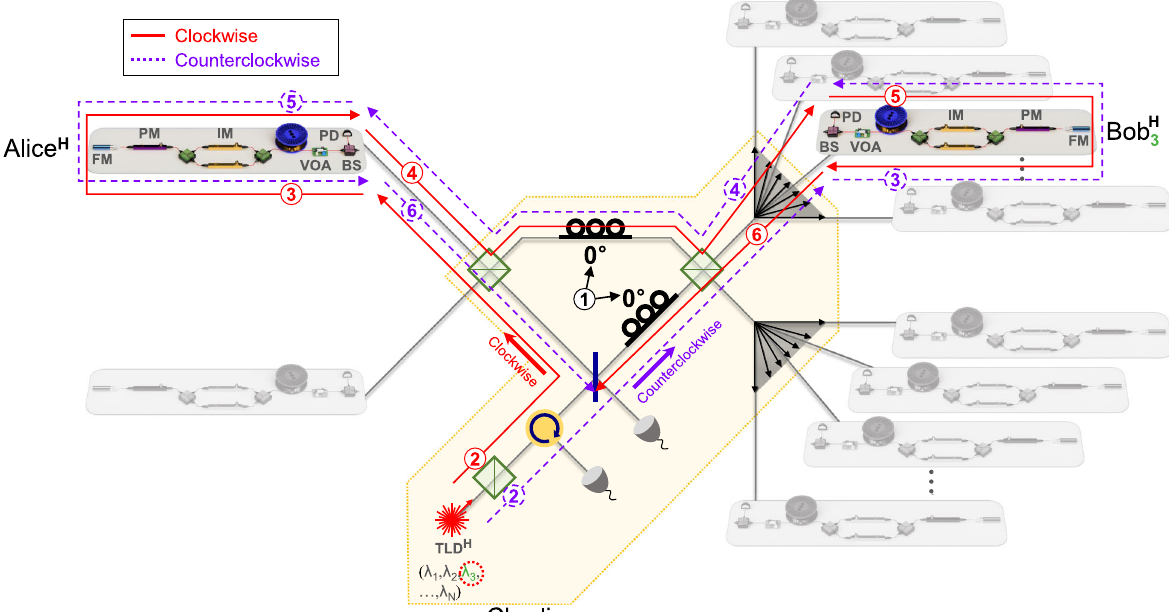
tunable laser driver, PD photodiode, VOA variable optical attenuator, IM intensity modulator, PM phase modulator, FM Faraday rotator mirror.